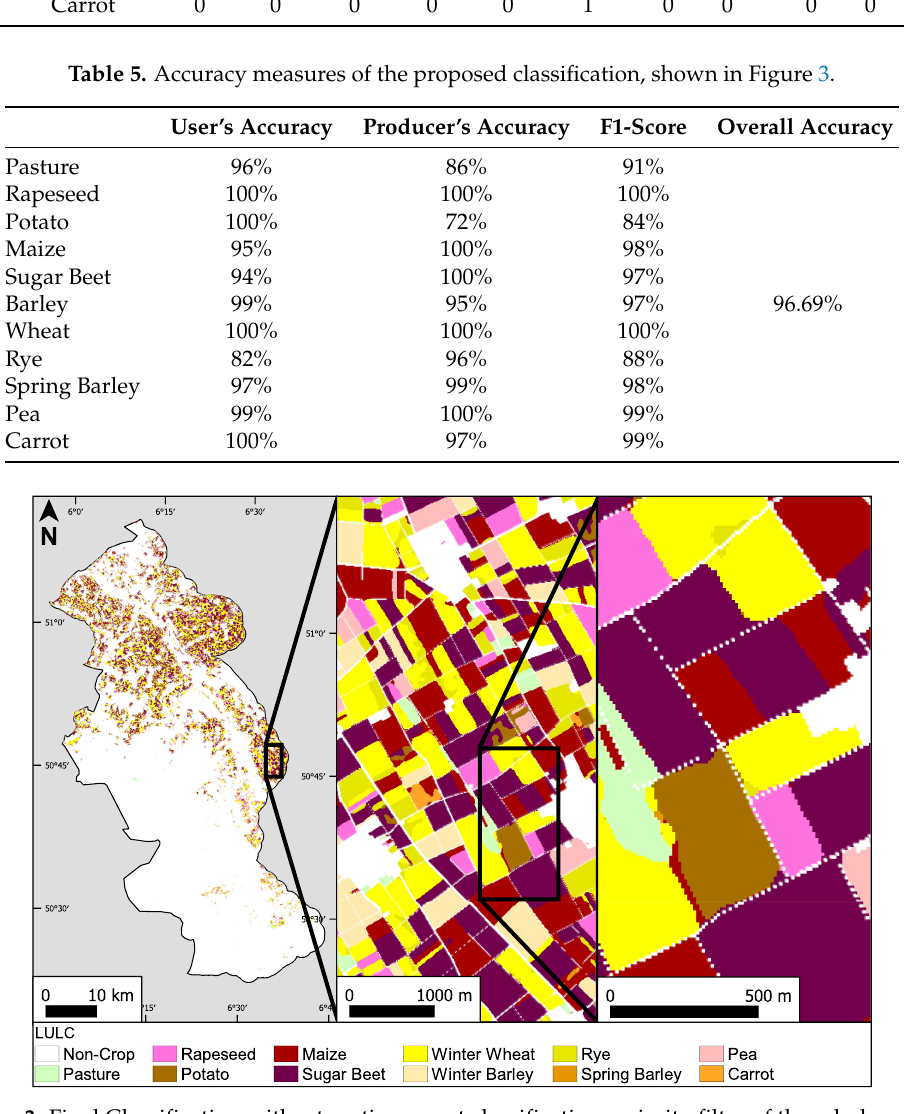
Figure 3. Final Classification with a two times post classification majority filter of the whole area of interest (AOI) covering about 2500 km 2